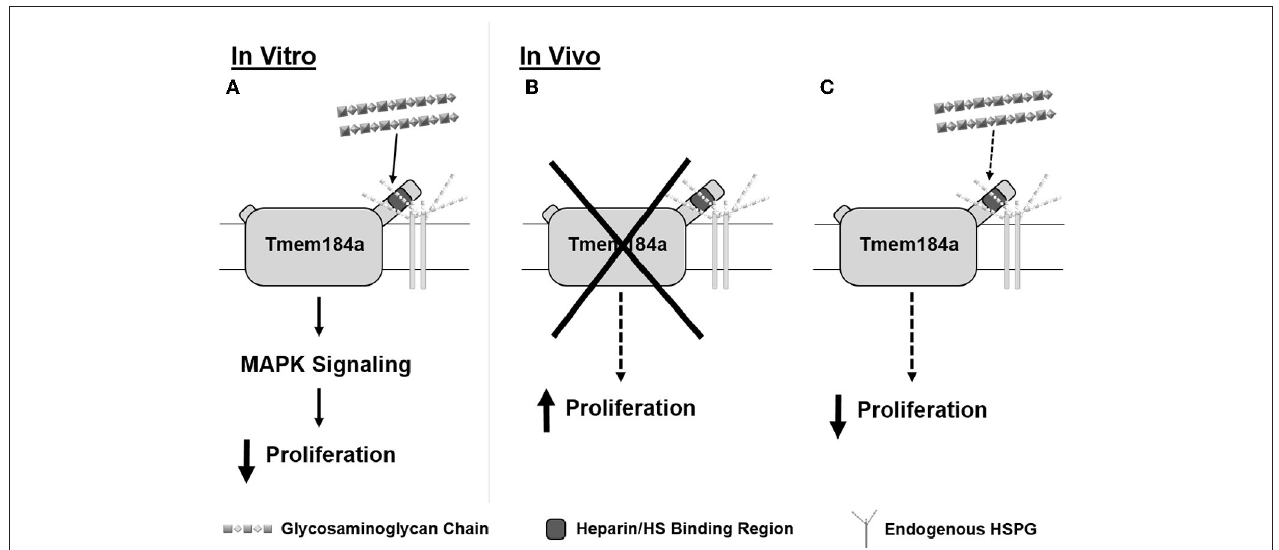
FIGURE 8 | Schematic summarizing heparin/HS-dependent Tmem184a effects on vascular cell proliferation in vitro and in vivo . We have shown Tmem184a is expressed specifically on vascular cells. (A) In vitro , we have shown that exogenous heparin binds specifically to TMEM184A to induce MAPK signaling which decreases proliferation. (B) When Tmem184a is knocked down in vivo , cell proliferation increases. (C) Administration of excess heparin in vivo will also decrease cell proliferation, even though endogenous HS are